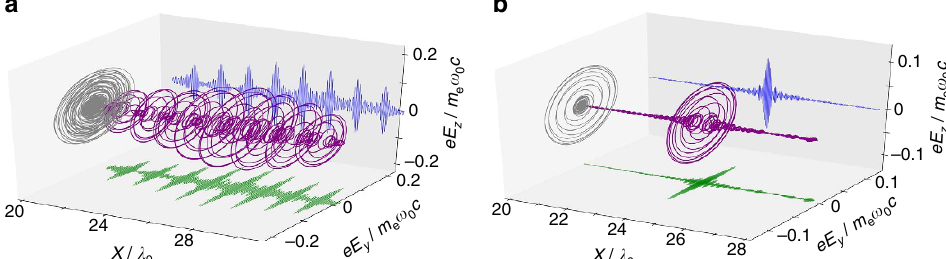
Figure 3 | Attosecond helical XUV pulses. ( a ) Waveform of a CP XUVattosecond pulse train after spectral filtering where the 15th–20th harmonic orders are selected. Here an EP laser pulse of 30fs duration is used. ( b ) Waveform of a CP XUV isolated single attosecond pulse after spectral filtering where the 35th–42nd harmonic orders are selected. Here a few-cycle EP laser pulse of 5fs duration is used. The other parameters are: laser amplitude a 0 ¼ 5; laser L initial phase f L 1 : 822; laser incidence angle y ¼ 40 (cid:2) ; plasma density n e ¼ 200 n c ; and plasma scale length L s ¼ 0.1. In both panels, waveform of the 3D z (cid:2) f y ¼ electric field vector (purple), the two orthogonal electric field components E y (green) and E z (blue) and the projection of E y (cid:2) E z (grey) are